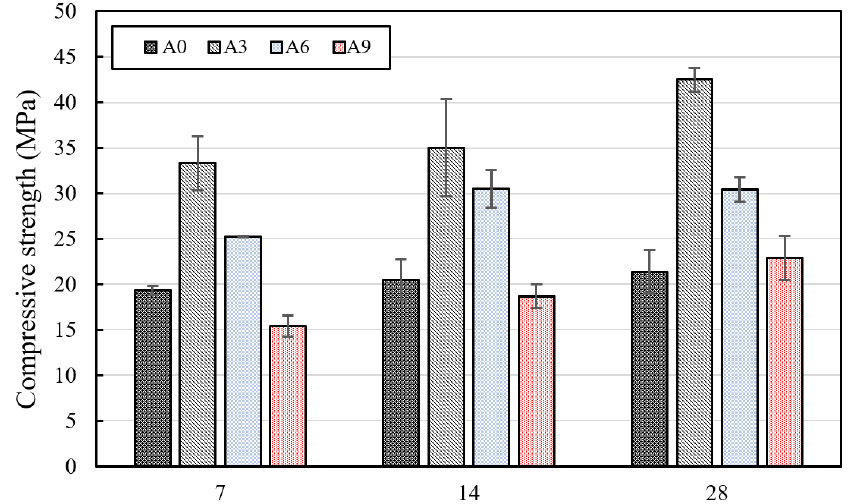
Figure 8. Compressive strengths of the mortar specimens on the 7th, 14th, and 28th